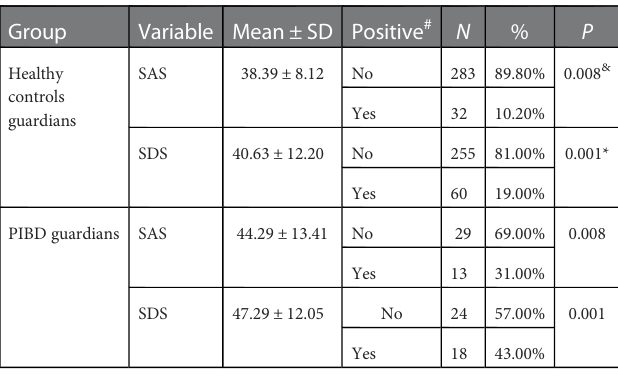
TABLE 5 The SAS and SDS of guardians during COVID-19.